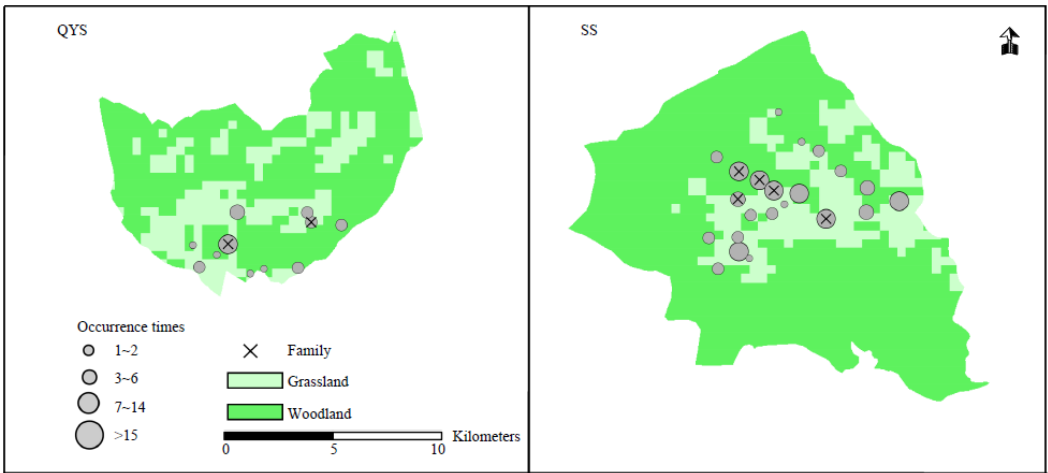
Figure 2. Distribution of independent captures and family sites for the lynx in Qingyunshan (QYS) and Shengshan (SS).